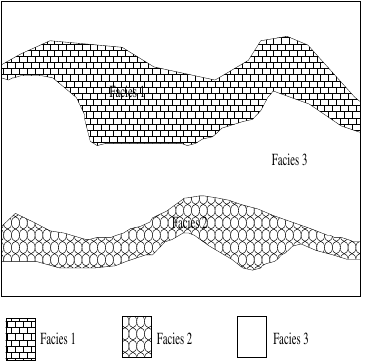
Figure 1. Illustration of the permeability field with